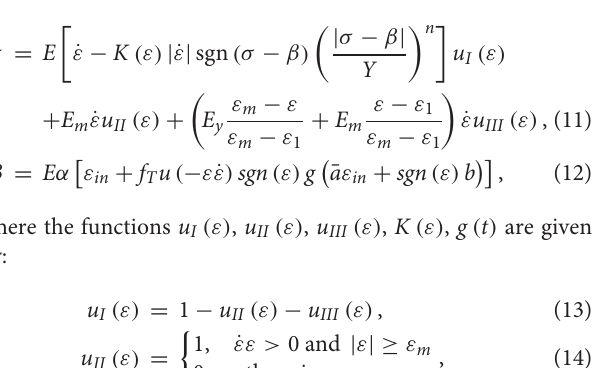
stability of numerical simulation and speed up the computation